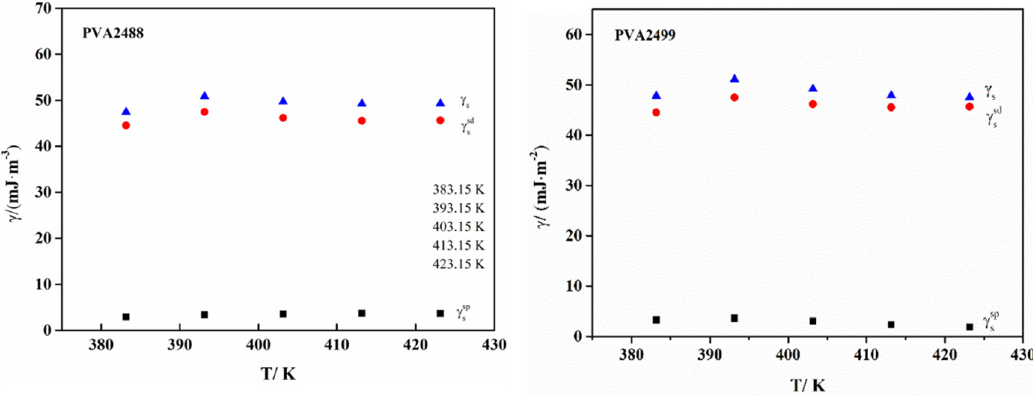
Figure 6. Surface energy of PVA2488 and PVA2499 at different temperatures. Table 8. Dispersive component γ (cid:2929)(cid:2914) , specific component γ (cid:2929)(cid:2914) , and total surface energy γ (cid:2929) of PVA2488 and PVA2499 at different temperatures. T/K